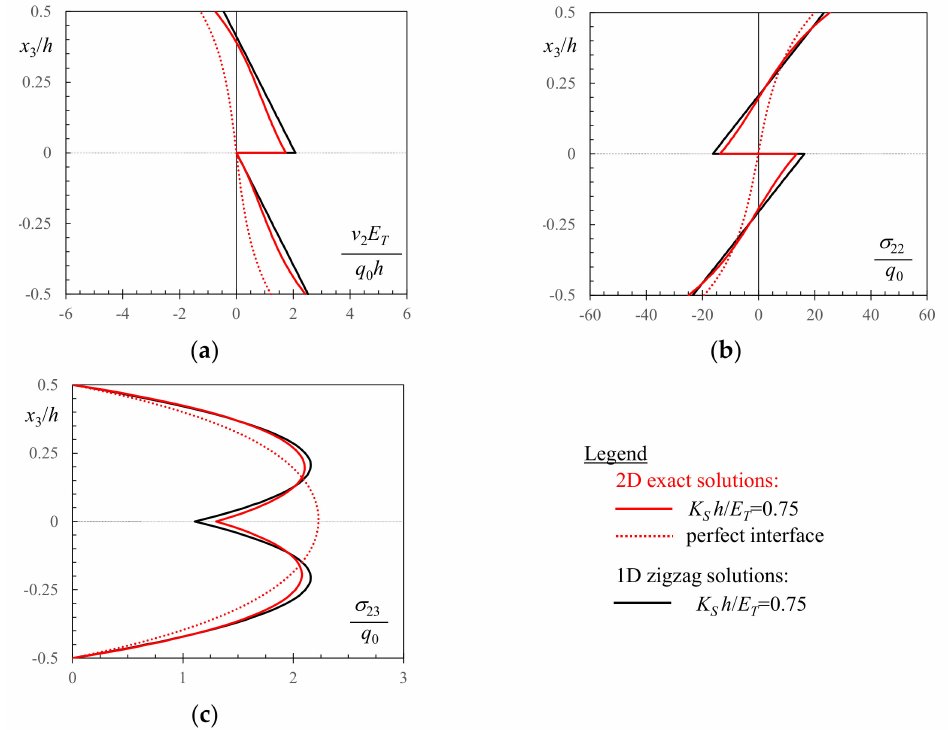
Figure 3. 2D exact and 1D zigzag solutions for simply supported two-layer beam (0 ◦ /0 ◦ ) with L / h = 5 subjected to sinusoidal transverse load: ( a ) local longitudinal displacements (at x 2 = 0); ( b ) bending stresses (at x 2 = 0.5 L ); ( c ) transverse shear stresses (at x 2 = 0) determined from local equilibrium. The red dotted lines correspond to the 2D exact solution for perfectly bonded